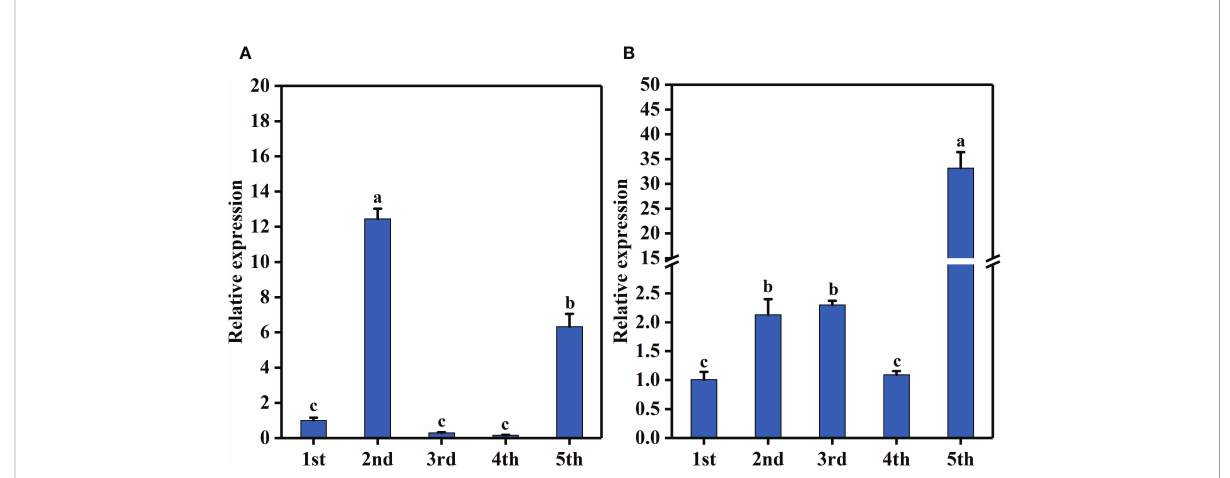
FIGURE 5 Expression levels of BraA07g041560.3C and BraA07g041570.3C in CX020 rosette stem at different stages based on qRT-PCR. (A) The expression level of BraA07g041560.3C. (B) The expression level of BraA07g041570.3C. The data shown are the means of three replicates (± SD). The different lowercase letters above the means are signi fi cantly different at P=0.05 level.